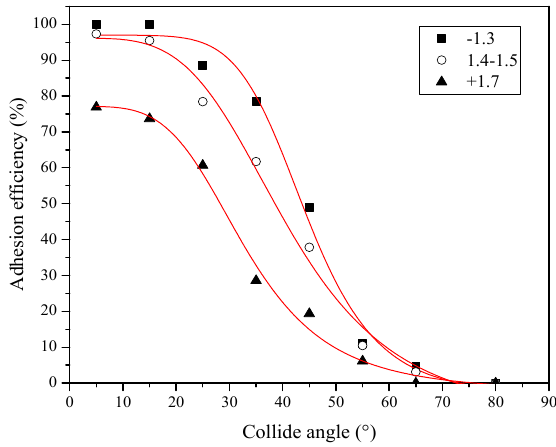
Figure 14. Adhesion efficiency of coal samples.